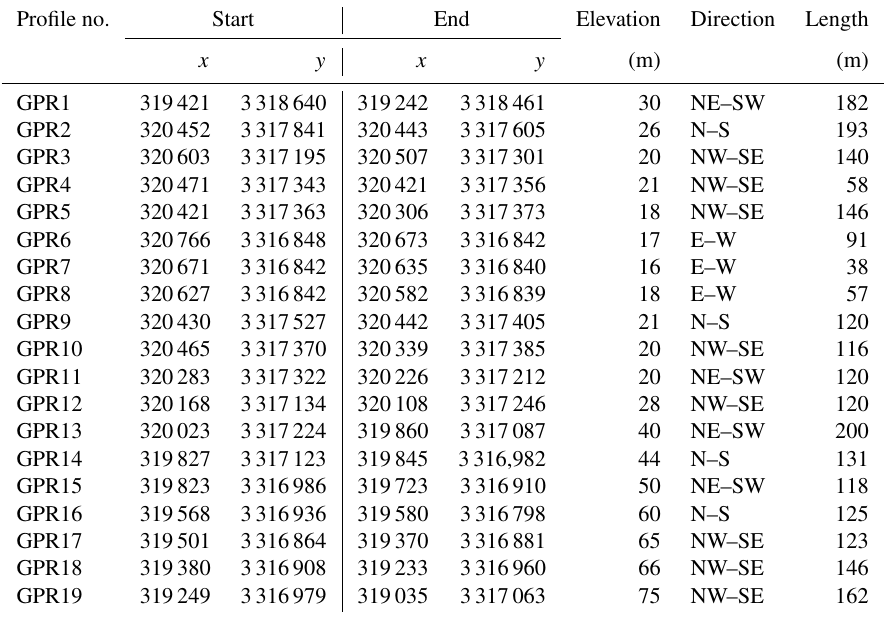
Table 3. Main characteristics of GPR profiles. Profile